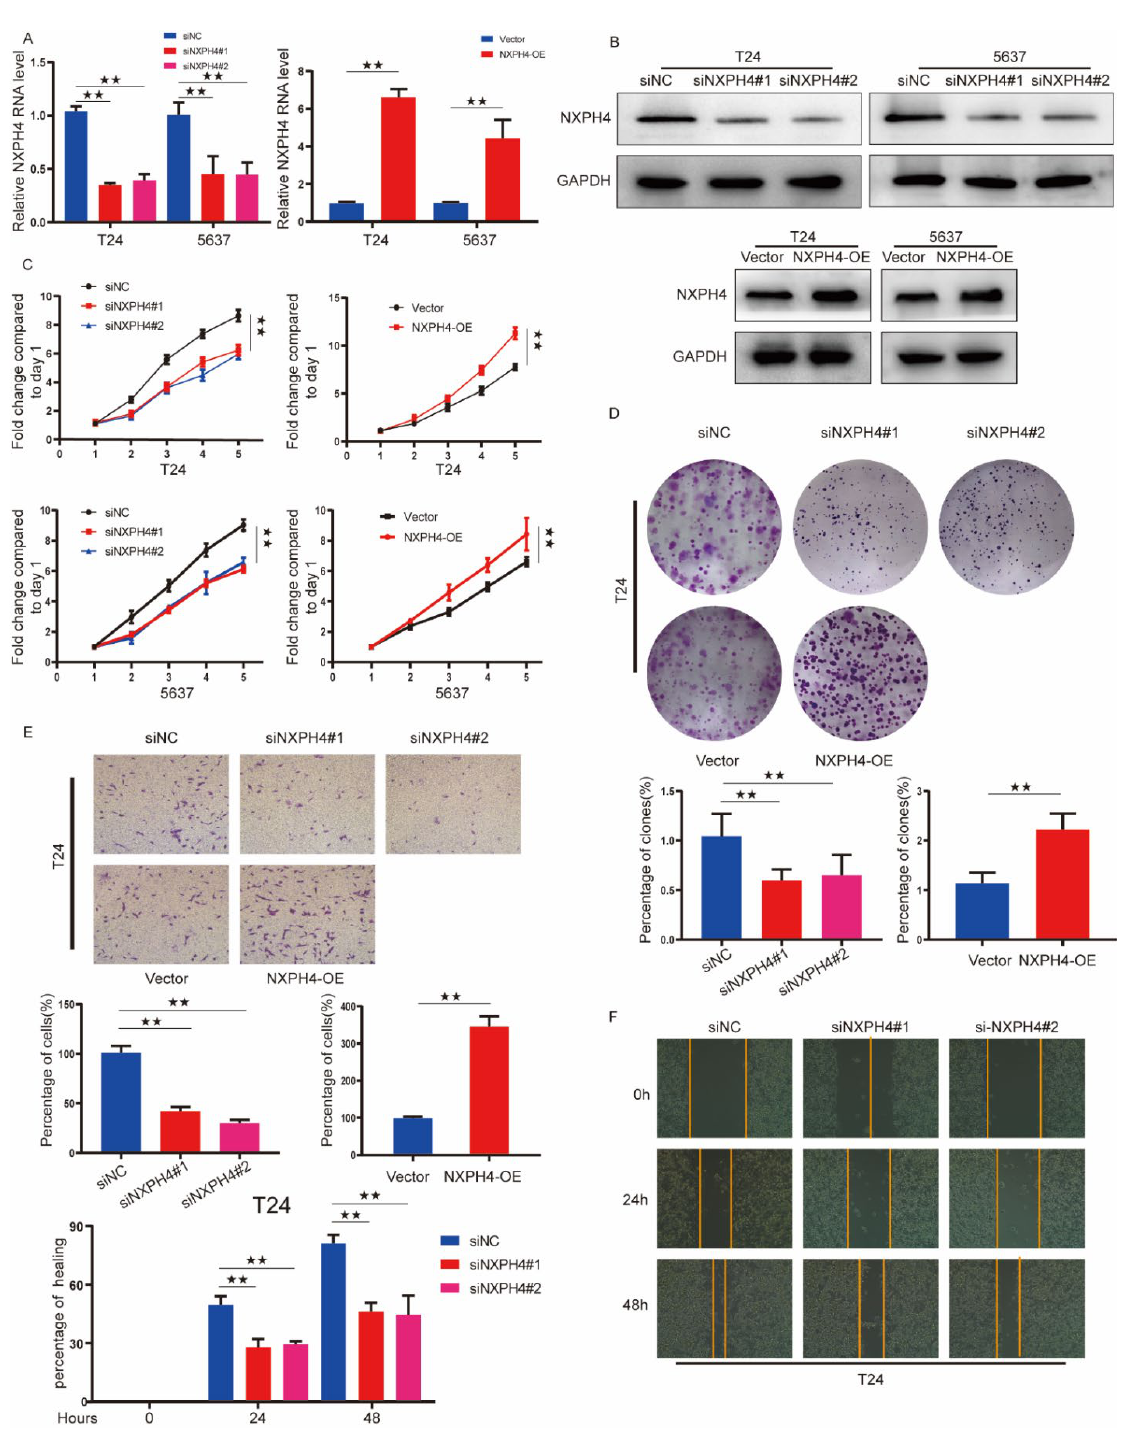
Figure 4. Knockdown or overexpression of NXPH4 altered BC cell invasion and proliferation. ( A ) NXPH4 knockdown or overexpression efficiency in T24 and 5637 cells was analyzed by qRT-PCR. ( B ) NXPH4 knockdown or overexpression efficiency in T24 and 5637 cells was analyzed by Western blot. ( C , D ) The effect of NXPH4 knockdown or overexpression on T24 and 5637 cell proliferation was measured via CCK-8 and colony formation assay. Five microscopic fields were chosen at ran- dom and averaged. ( E , F ) The effect of NXPH4 knockdown or overexpression on invasion and mi- gration was analyzed using Transwell and wound healing assays in T24 cells, respectively. The lower histogram represents relative cell number while the representative images are shown on the